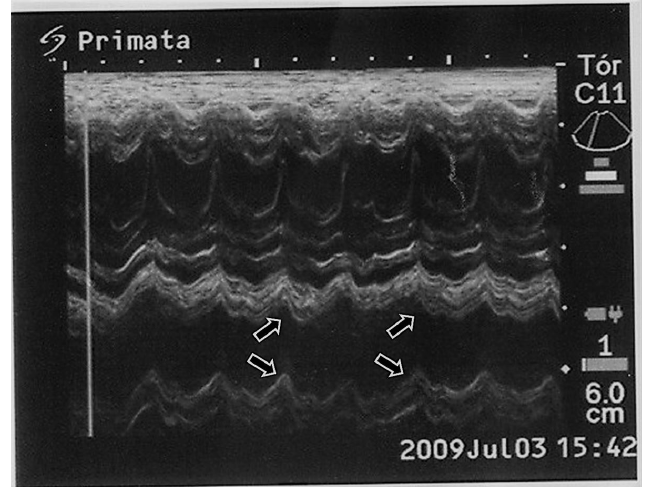
Figure 3. Echocardiographic examination in two-dimensional mode, indicating low shortening fraction (arrow outlines), and consequent reduction in systolic function. Results compared to established reference values for dog.